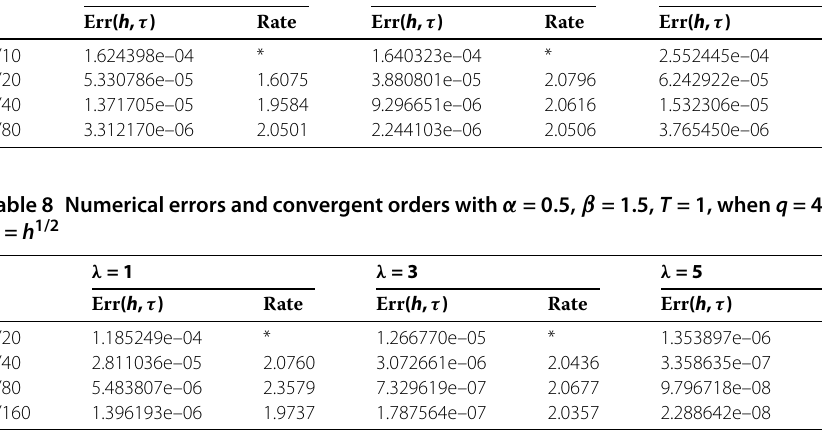
Table 7 Numerical errors and convergent orders with α = 0.5, λ = 2, T = 1, when q = 1, τ = h 2 h